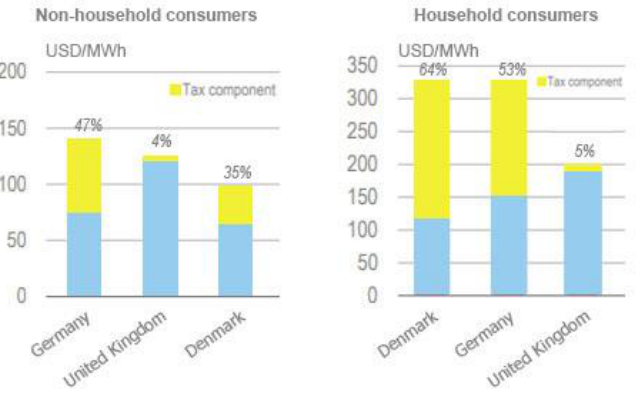
Figure 2. Industry and household electricity prices and their taxation component in Germany, Denmark, and the UK, 2016. Source: our own elaboration from IEA [61].